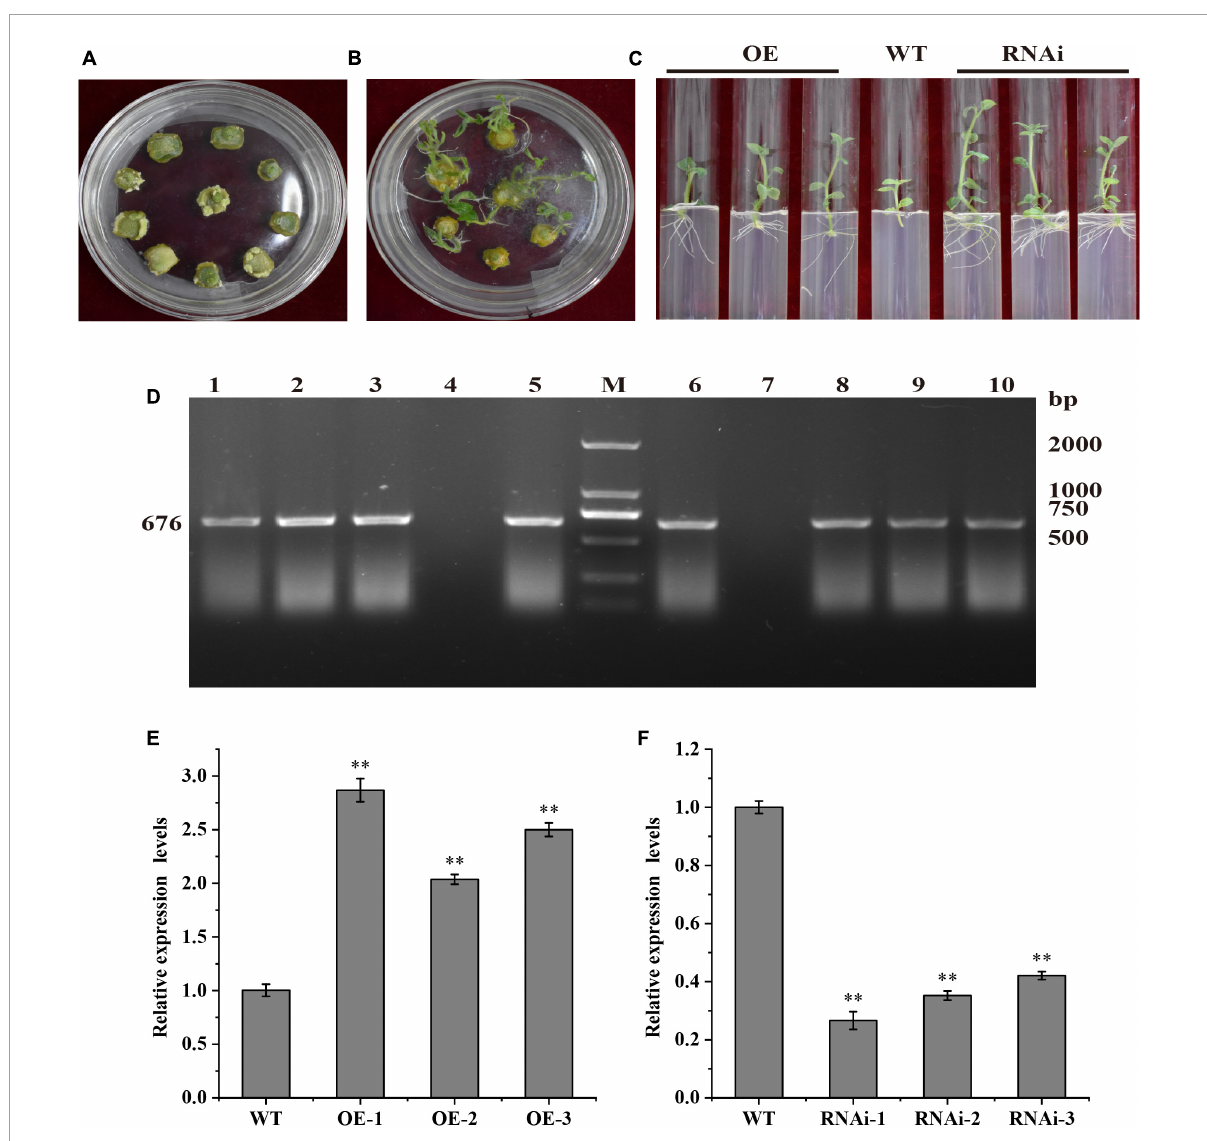
FIGURE3 Acquisition and identification of transgenic potato. (A) Calli; (B) Differentiation and rooting transgenic plants; (C) Rooting and screening transgenic plants. OE, Transgenic plant “Desiree” carrying recombinant plasmids pBI121-StTCP15; WT, Wild-type plant “Desiree”; RNAi: Transgenic plant “Desiree” carrying recombinant plasmids pCPB121-amiR-StTCP15. (D) PCR detection of transgenic plants. M: DL 2000 marker; 1–3: pBI121-StTCP15 transformed plants; 4: Negative control; 5: Positive control pBI121-StTCP15 plasmid; 6: Positive control pCPB121-amiR-StTCP15 plasmid; 7: Negative control; 8–10: pCPB121-amiR-StTCP15 transformed plants. (E,F) The relative expression level StTCP15 in the transgenic plants and WT plants. WT: Wild-type tubers of “Desiree”; OE-1 ∼ OE-3: Transgenic tubers of “Desiree” carrying recombinant plasmids pBI121-StTCP15; RNAi-1 ∼ RNAi-3: Transgenic tubers of “Desiree” carrying recombinant plasmids pCPB121-amiR-StTCP15. Each column represents the mean values ± SE ( n = 3; ∗ P < 0.05; ∗∗ P <